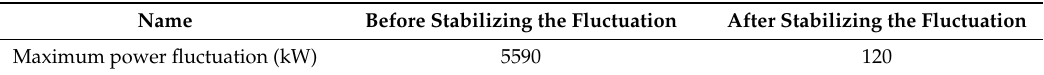
Table 8. Maximum fluctuation of system output. Figure 10. System output before and after stabilizing fluctuation in scenario 2.